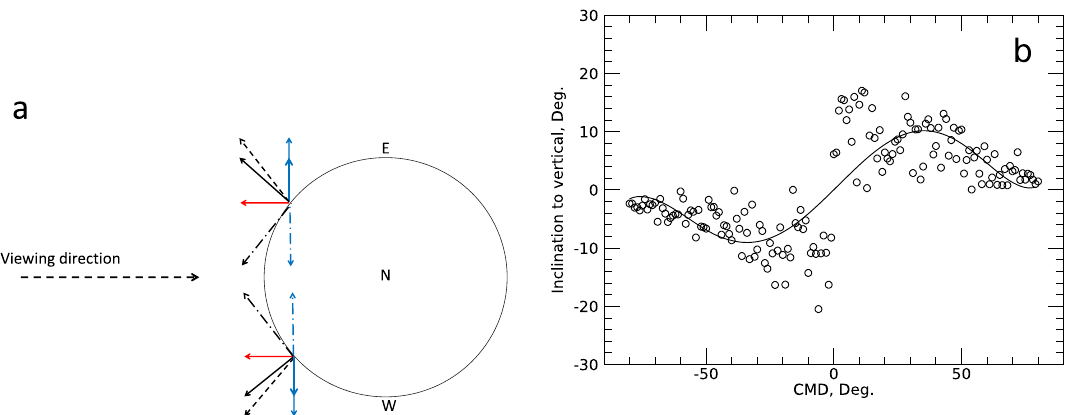
Fig. 2. Effect of noise in the transverse fi eld on the derived orientation of the vector fi eld. (a) Black arrows represent the true vector fi eld on the Sun (radial in this example). Red arrows represent the line-of-sight component and thick blue arrows are transverse components of the true vector fi eld. Adding positive noise to the transverse fi eld (thin blue arrows) makes the observed fi eld (dashed arrow) systematically inclined in the direction away from the central meridian. Because of the 180 (cid:1) azimuthal ambiguity in the transverse fi eld, the same transverse fi eld may satisfy an alternative orientation (dashed-dotted arrow). The resulting orientation of the fi eld vector is shown by a dashed arrow for both locations. Letters E, W, N mark approximate positions of solar East limb, West limb, and North as seen from Earth. (b) Difference between the true radial direction and vector orientation in the presence of noise, when azimuth disambiguation selects the most radial of two possible solutions (open circles). Solid line is a 6th degree polynomial fi